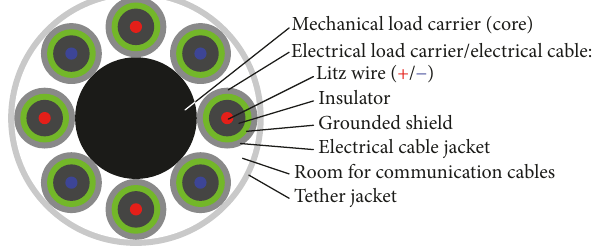
Figure 8: Considered tether